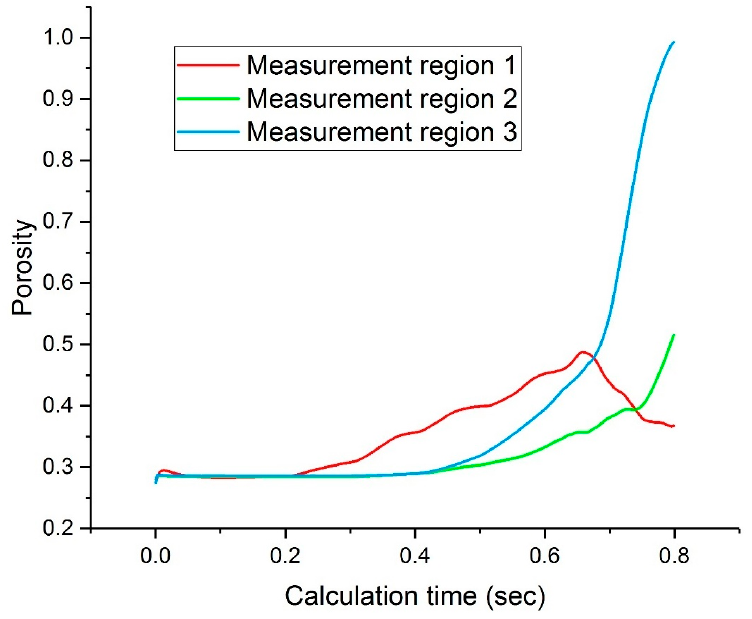
Figure 19. Evolution of porosity in different measurement regions.